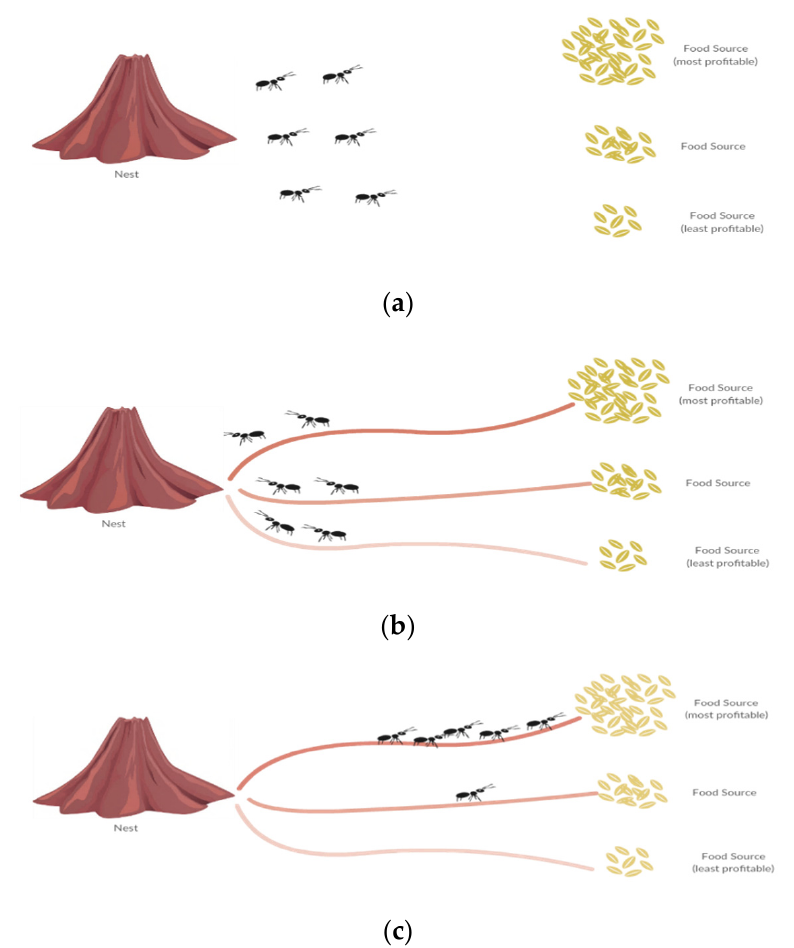
Figure 1. Ant foraging behavior. ( a ) With no pheromone trail in the environment, ants start exploring the environment randomly. ( b ) Ants return to the nest while depositing a pheromone trail proportional to food source profitability. ( c ) Other ants take the path that has the highest density of pheromone. The pheromone on the trails to less profitable sources evaporates gradually, while it becomes more concentrated on the path to the more profitable